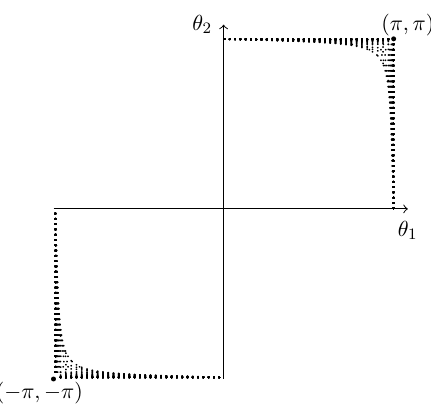
Figure 3 . A connected component of the coamoeba(shaded) of b ( z ) = 1 + z 1 + z 2 + cz 1 z 2 drawn in the fundamental domain [ (cid:0) (cid:25); (cid:25) ] (cid:2) [ (cid:0) (cid:25); (cid:25) ] of T 2 in R 2 . The coe(cid:14)cient c is near